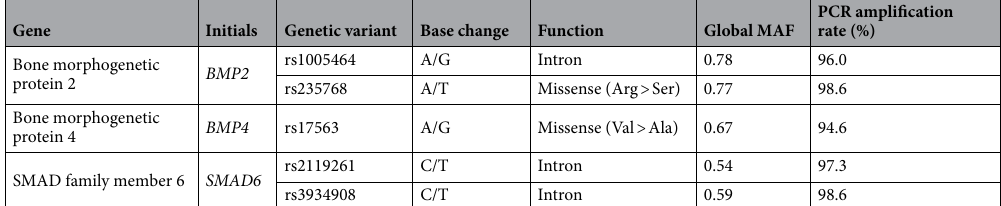
Table 4. Characteristics of the selected genetic variants. MAF means minor allele frequency. Data obtained from databases: https:// www. ncbi. nlh. nih. gov/ snp/; http:// genome. uscs. edu/; and, https:// www. therm ofish er. com/. Arg means Arginine, Ser means Serine, Val means Valine, and Ala means alanine.